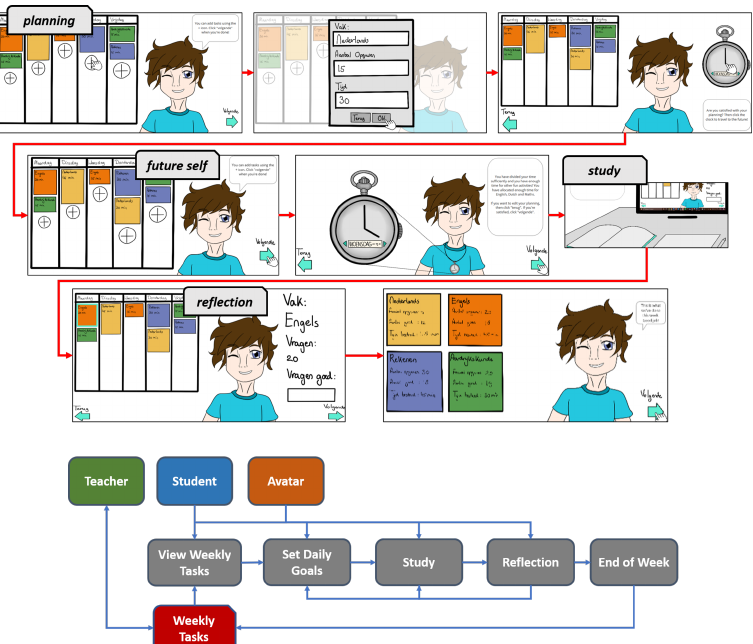
Figure 1. Interaction scenario. The system helps the student to identify an appropriate daily plan based on a given weekly goal provided by the teacher. The student interacts with a drag-and-drop scheduling interface to set their daily goals. The student interacts with the avatar to get insights about the possible learning outcomes of their plan, as well as of alternative plans, in the form of possible future selves. The goal is to help the students identify an appropriate plan on their own (learner agency). The predicted and actual learning outcomes can be visualized during the reflection session to help the student evaluate and modify their learning goals and